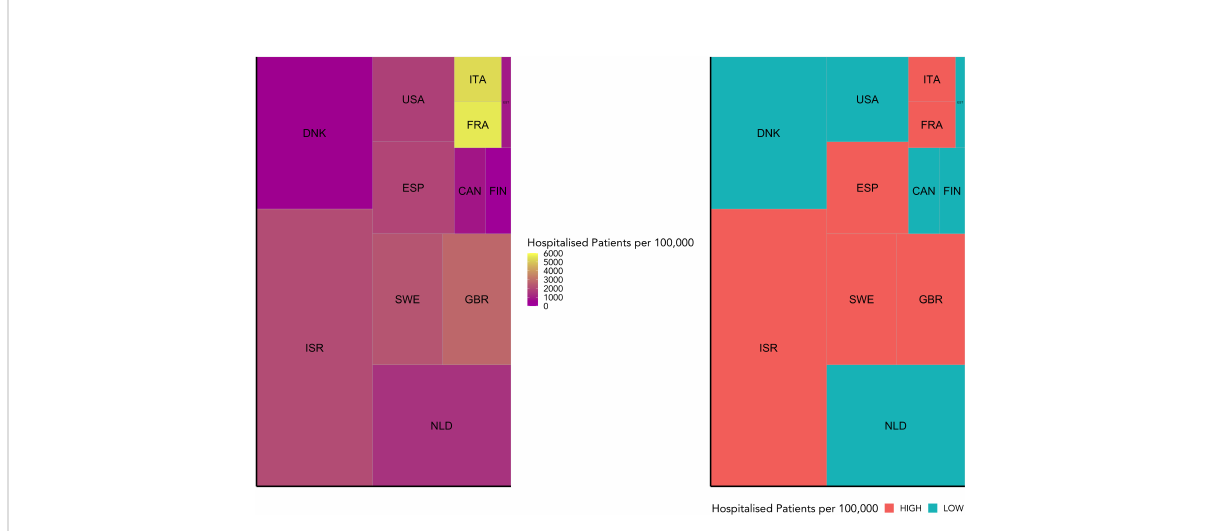
FIGURE 1 This fi gure visualises the weighted grouping of countries into COVID-19 severity groups. It shows the hospitalisation rate for each country included in this study relative to the number of microbiome samples available for that country. While the hospitalisation rate is indicated by colour, the sample size is represented by the area of each tile. On the left is the raw data, and on the right the grouping into high or low COVID-19 severity groups (high in red, low in blue) based on a weighted mean into even